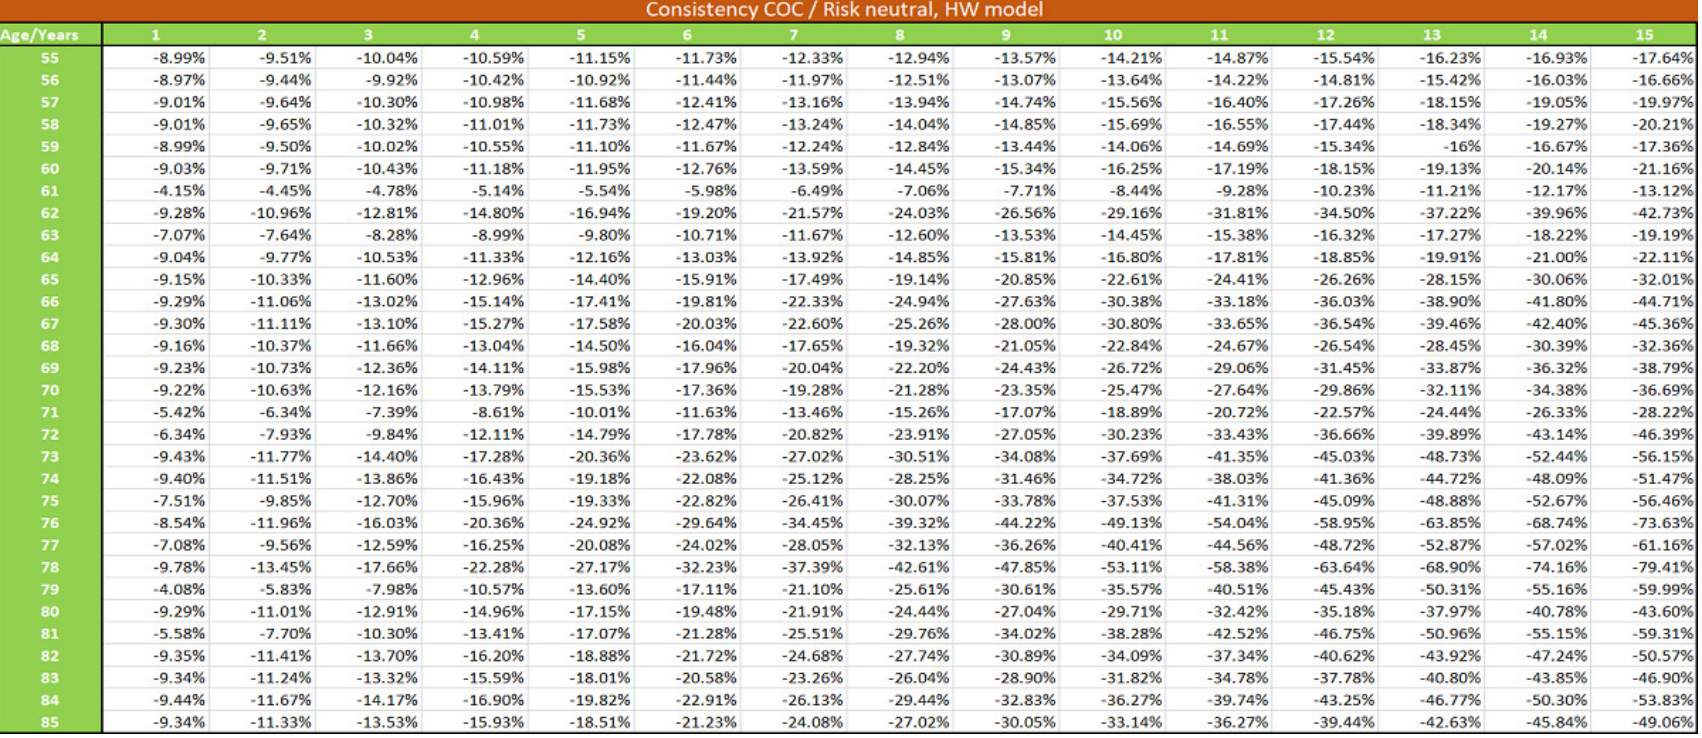
Figure A2. Consistency between risk-neutral and Cost of Capital method, HW